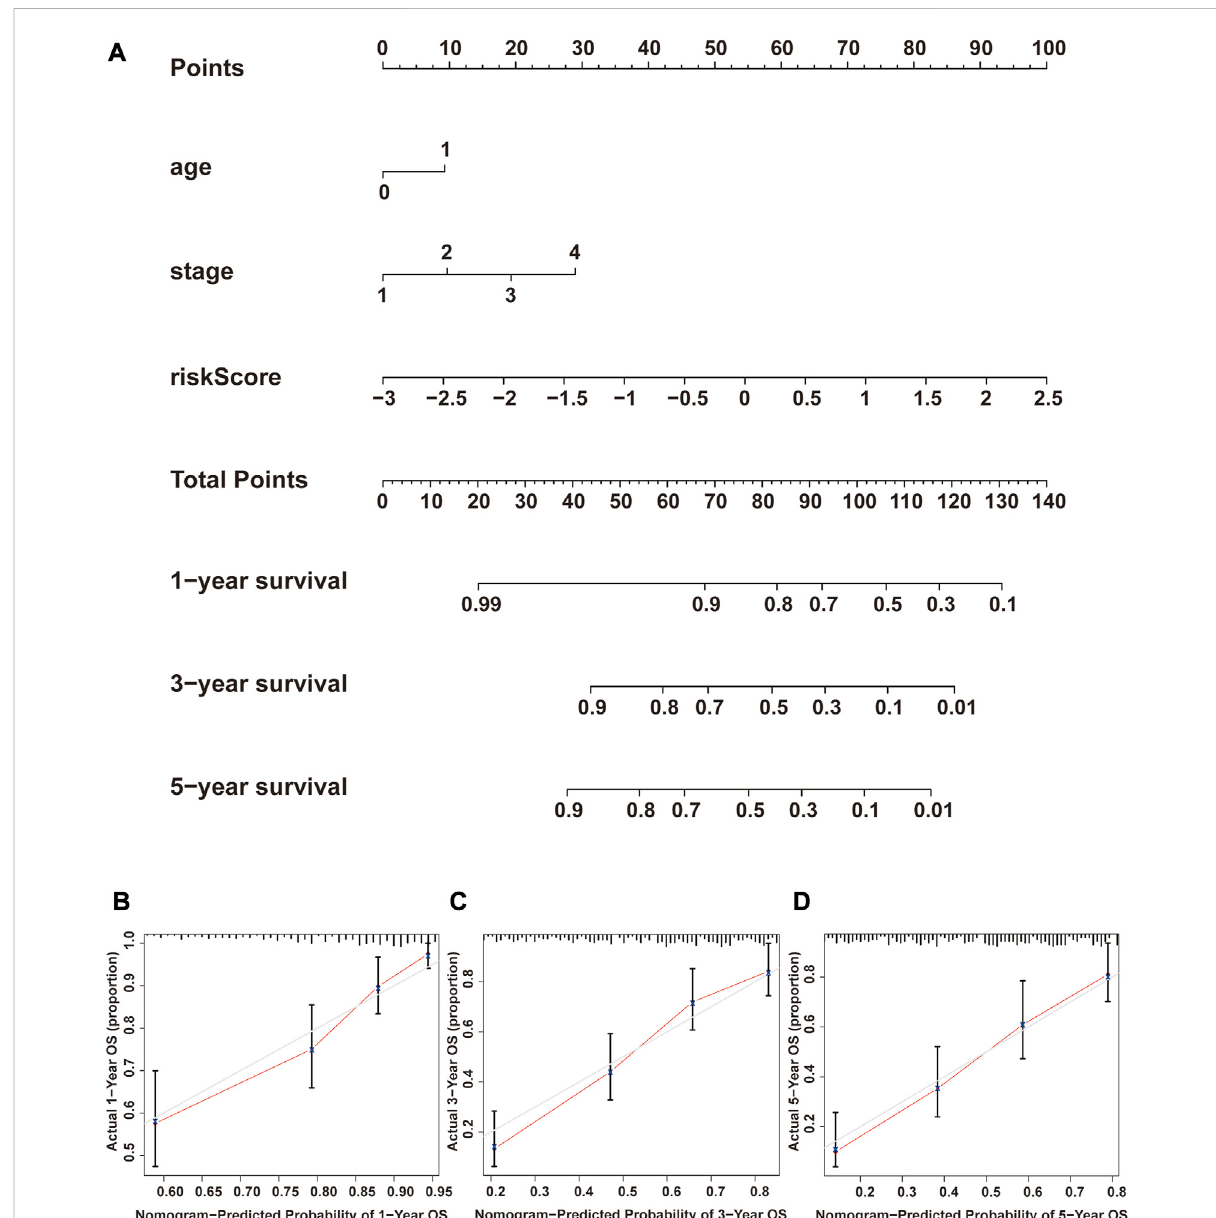
FIGURE 9 Construction and veri fi cation of the nomogram. (A) Nomogram combining clinicopathological variables and NRG score predicts 1-, 3-, and 5- yearOSofBLCApatients. (B – D) CalibrationcurvetestconsistencybetweentheactualOSratesandthepredictedsurvivalratesat1,3,and5years.N, lymph node; OS, overall